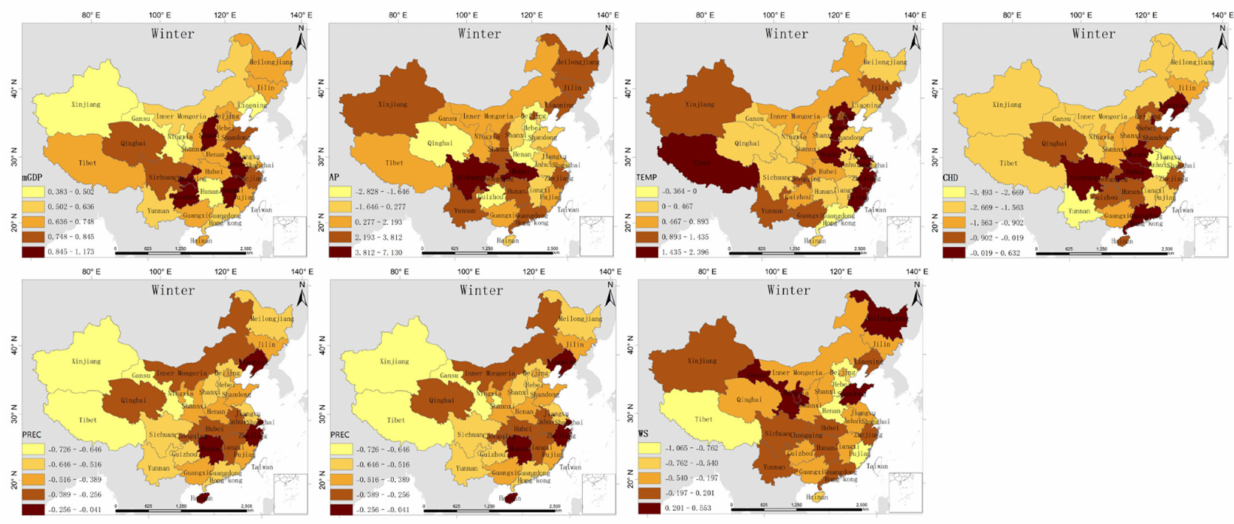
Figure 7. The spatial variations of the coefficients of the GWR model in winter. In spring, mGDP had the greatest influence on the I-HFMD in the southwestern and southeastern regions with a high I-HFMD, as shown in Figure 4. AP showed obvious spatial heterogeneity with inhibitory effects in northeastern, southwestern, and northwestern China but positive effects in the southeastern and northern regions. Furthermore, AP was positively associated with the I-HFMD in higher AP provinces but negatively associated with the I-HFMD in lower AP provinces. The influence of ALT also showed spatial non- stationarity, with an inhibitory effect in northeastern, southwestern, and northwestern China but a positive effect in northern, central, southern, and eastern China. Furthermore, ALT played an inhibitory role in high-altitude provinces and a positive role in low-altitude provinces. The more mountainous high-altitude provinces might isolate people, hampering the spread of HFMD. HU had a positive effect in all provinces and a higher